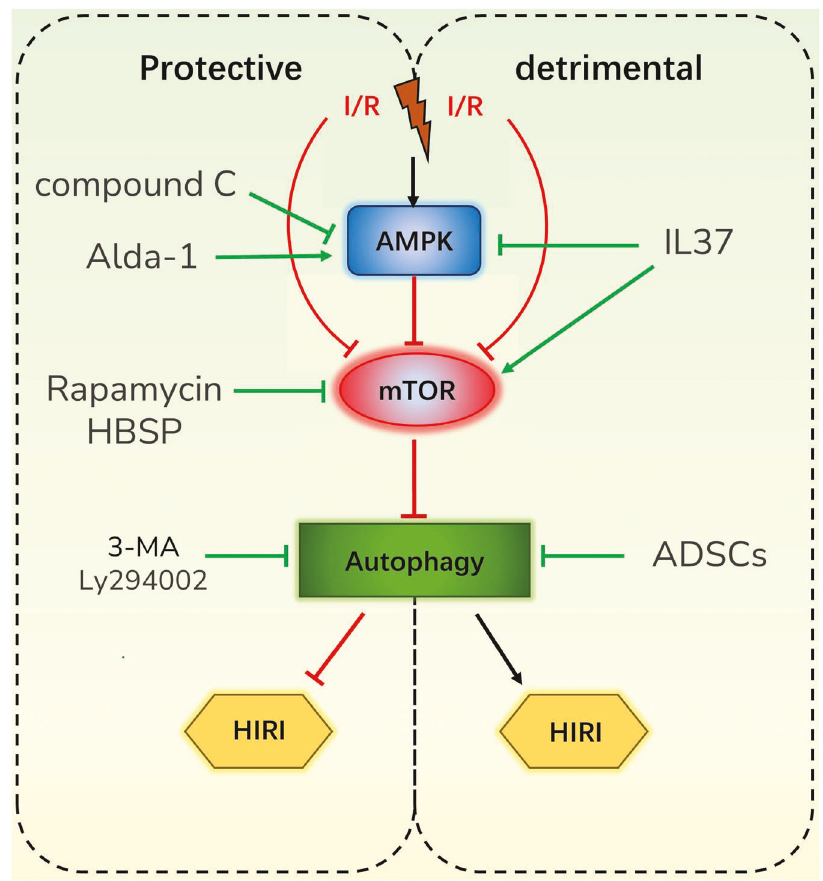
Fig. 2 Effects of autophagy on HIRI via the AMPK/mTOR pathway. Abbreviations: IL37 interleukin 37; 3-MA 3-methyladenine; HBSP Helix B surface peptide; Ly294002 Akt